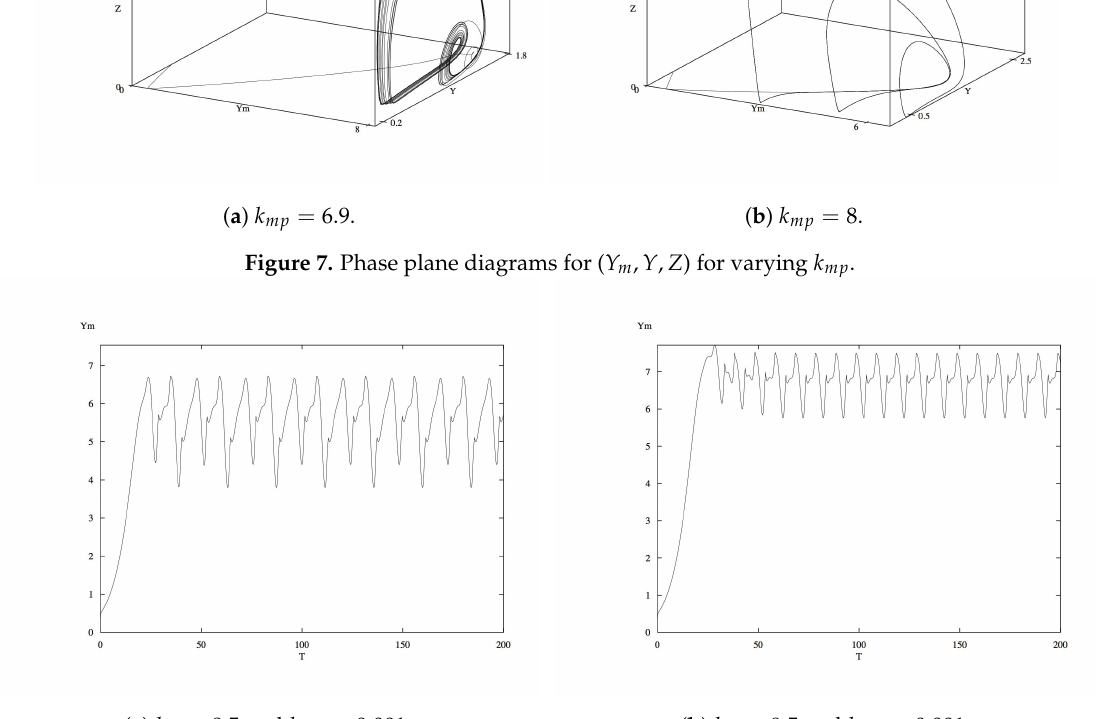
Figure 8. Time series for varying k w and k fm values. Other parameter values from Table